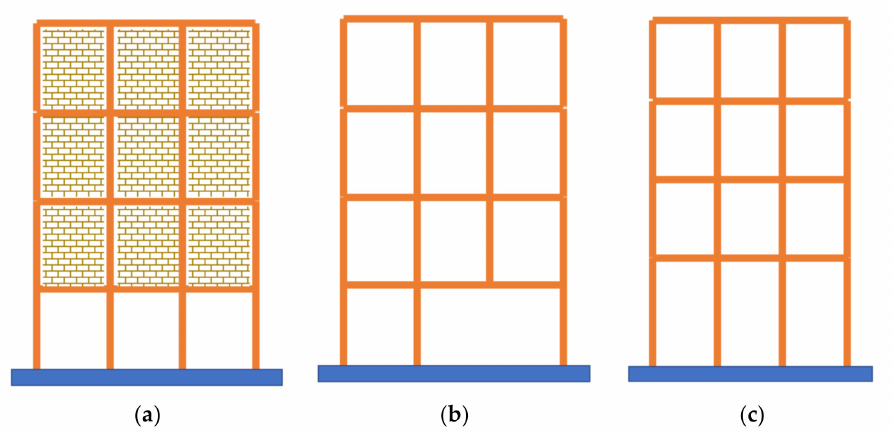
Figure 11. Structural configurations vulnerable to trigger out soft-storey mechanisms: ( a ) stiffness difference between storeys; ( b ) columns discontinuity; ( c ) height variations among the storeys.